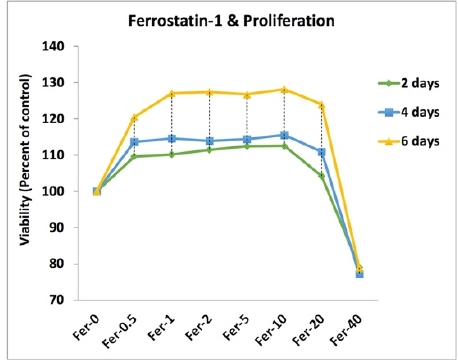
Figure 4. Doping effect of Fer-0, Fer-0.5, Fer-01, Fer-02, Fer-05, Fer-10, Fer-20, and Fer-40 on the MC3T3-E1 cells viability after 2, 4, and 6 days.